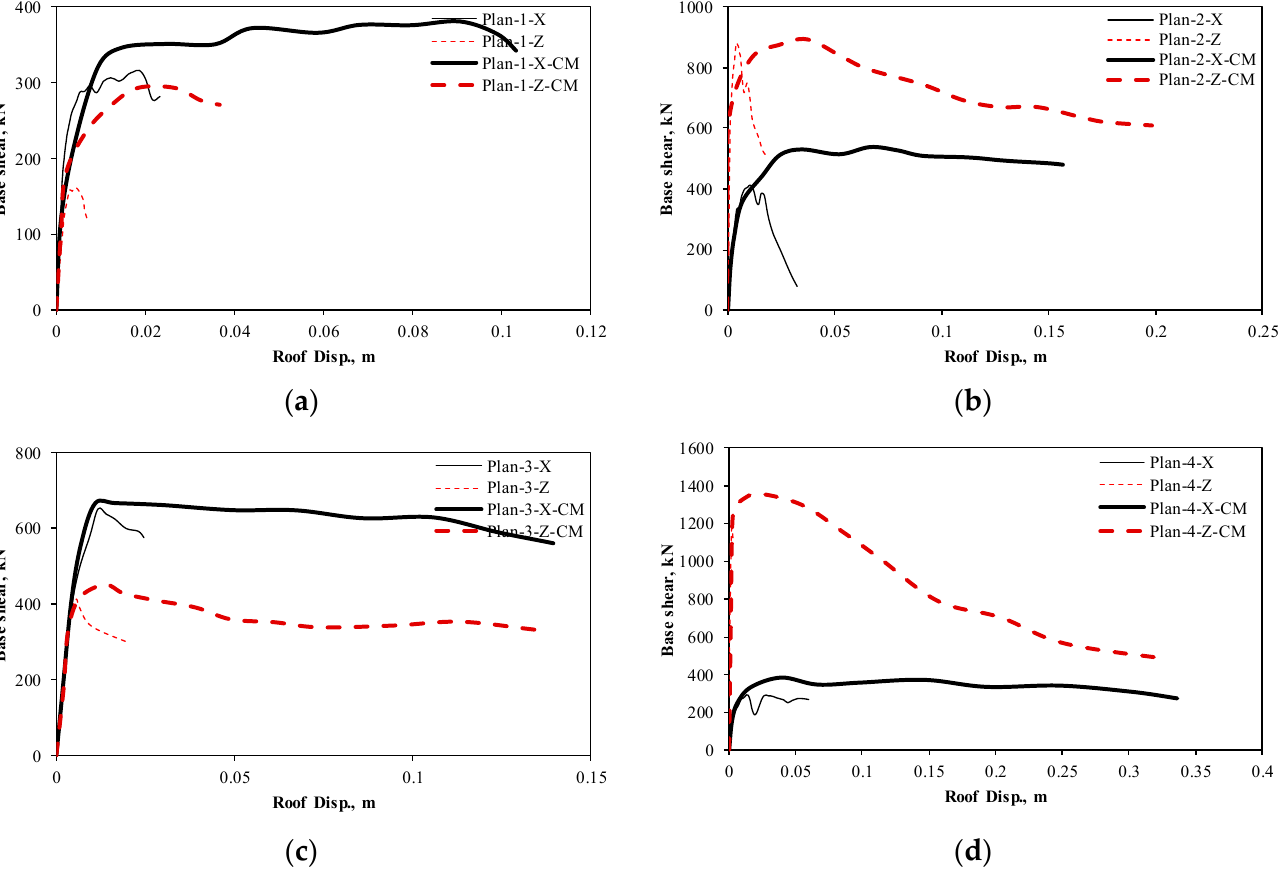
Figure 8. Lateral resisting force versus roof lateral displacement of URM and CM models in two directions: ( a ) Type-1; ( b ) Type-2; ( c ) Type-3; ( d ) Type-4.